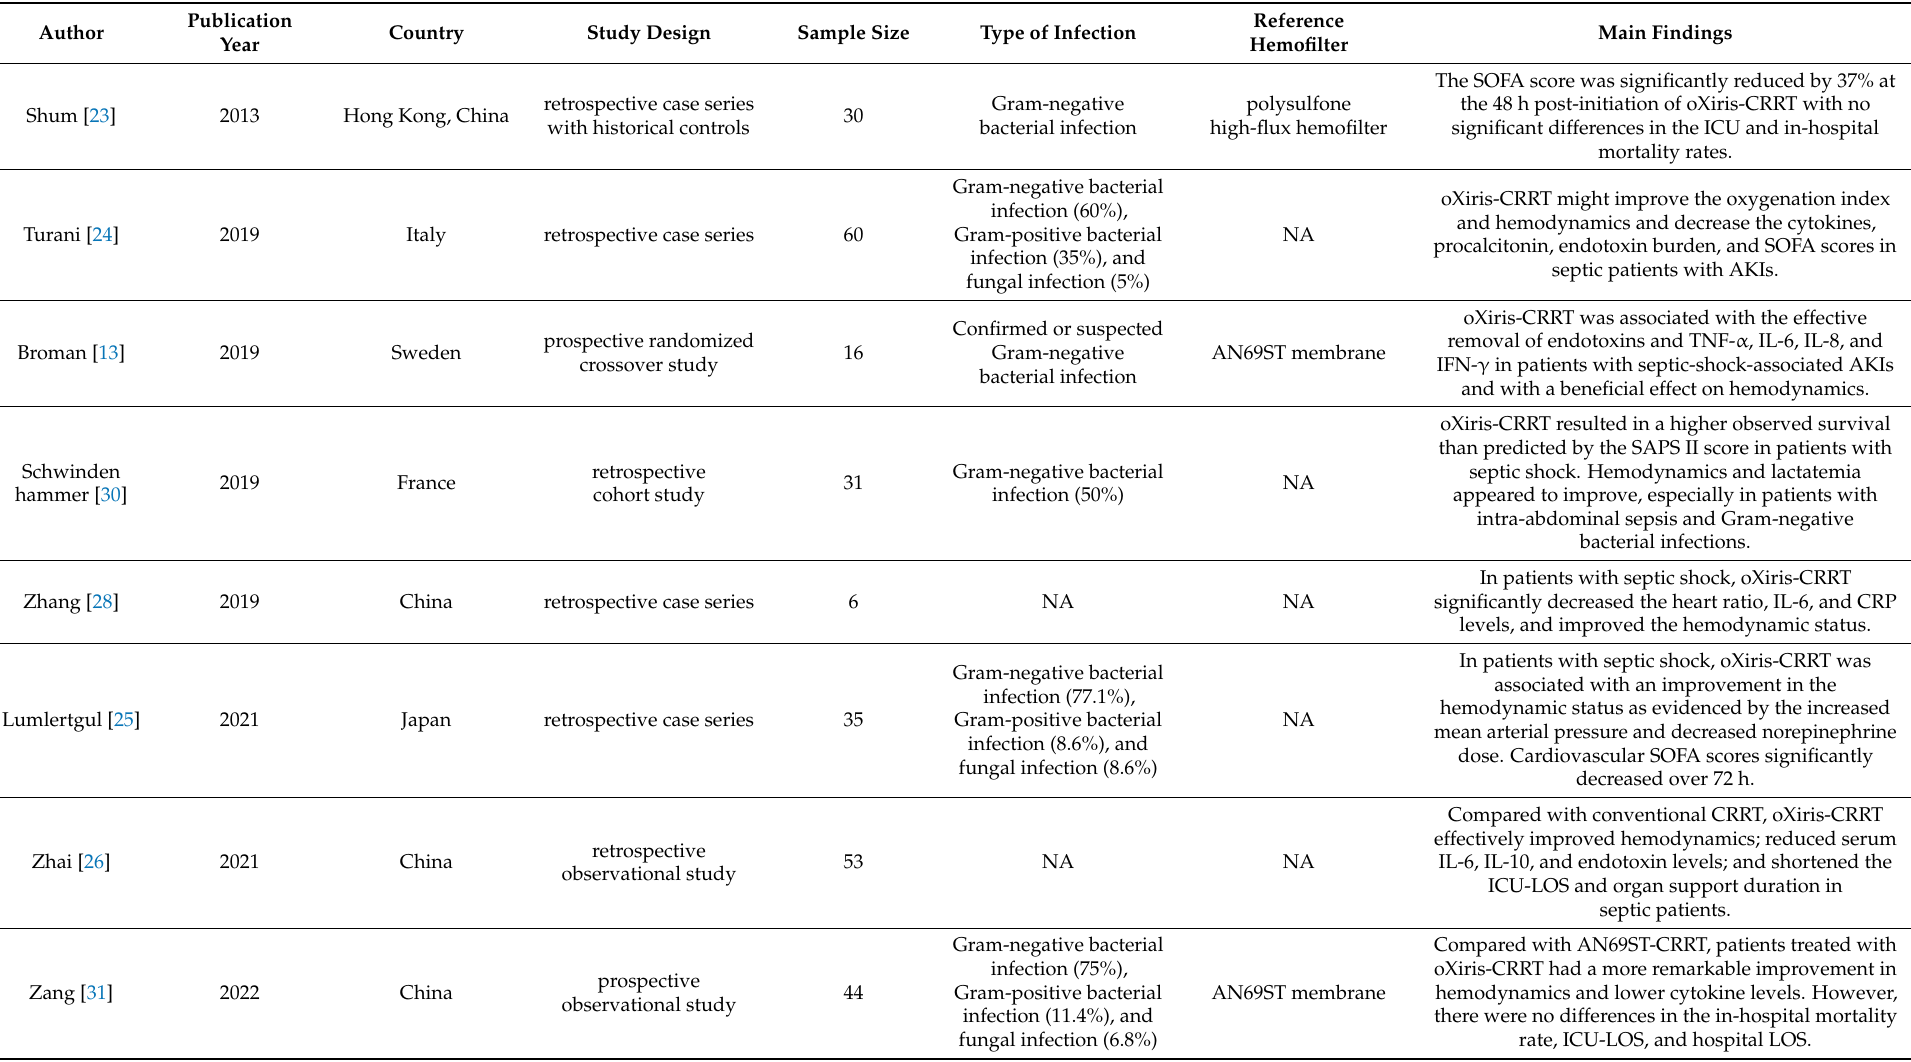
Table 1. Summary of main clinical trials evaluating oXiris-CRRT in septic